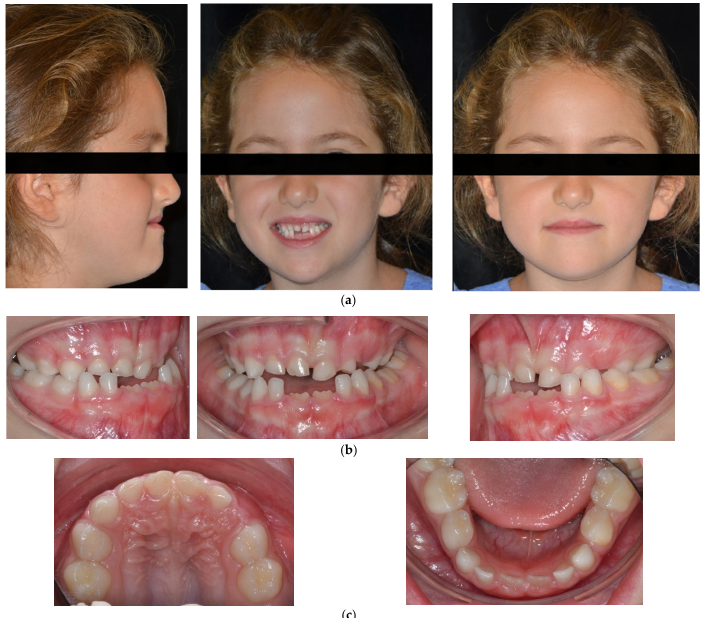
Figure 1. ( a ) Extraoral pre-treatment pictures: lateral and frontal views; ( b ) Intraoral pre-treatment pictures: lateral and frontal views; ( c ) Occlusal views: upper and lower arches.